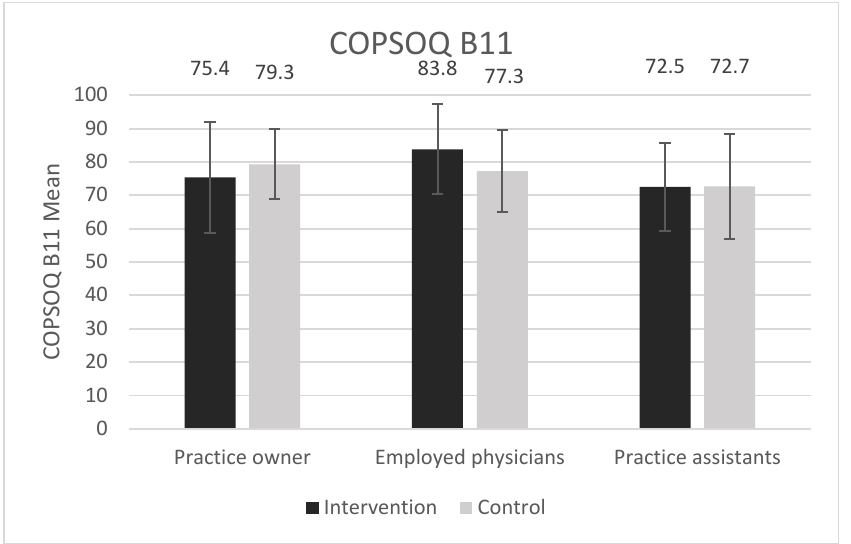
Figure 4. Job satisfaction (German COPSOQ, version 2018): mean scores of practice owners, em- ployed physicians and practice assistants for intervention and control group. Error bars show standard deviations. There are no significant differences between groups at baseline ( p > 0.05).